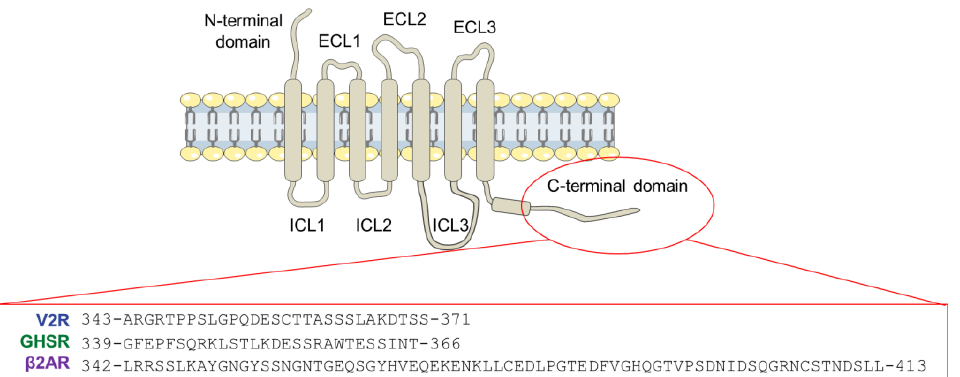
Figure 1. Schematic representation of a GPCR. GPCRs share a common core domain with seven transmembrane helices (7TM) linked by extracellular (ECL) and intracellular (ICL) loops. These loops, as well as the N- and C-terminal domains, are variable in length and sequence. The sequences of the three peptides used in this study are indicated just below.